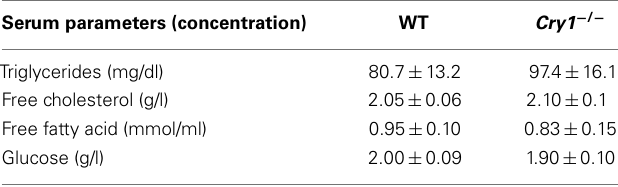
Values shown are mean ± SEM. WT, wild-type; HFD, high-fat diet. Shown are basal plasma lipids concentration, triglycerides (mg/dl), free cholesterol (g/l), free fatty acid (mmol/ml), and basal glycemia (g/l) in WT control Cry1 + / + and Cry1 − /